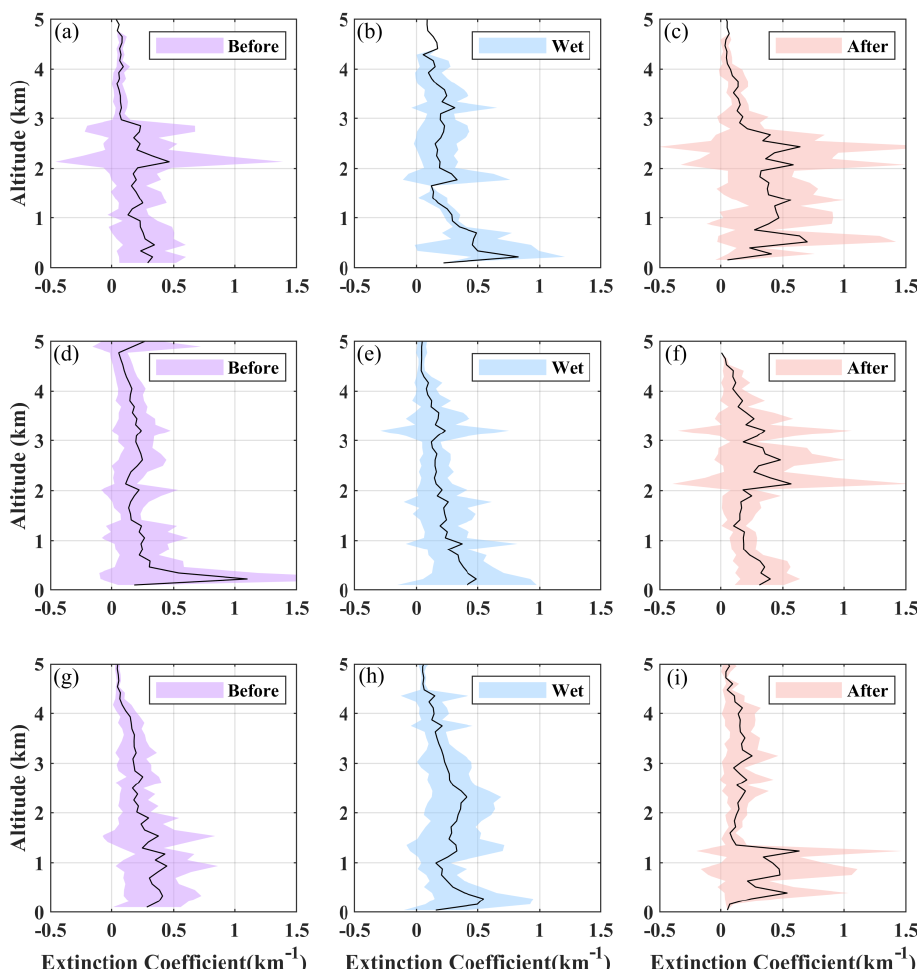
Figure 7. Extinction coefficient of aerosols under different stages and levels in February and March from 2012 to 2021. ( a – c ) Slight humidity, ( d – f ) moderate humidity, and ( g – i ) heavy humidity; ( a , d , g ) before-stage, ( b , e , h ) wet-stage, and ( c , f , i ) after-stage.